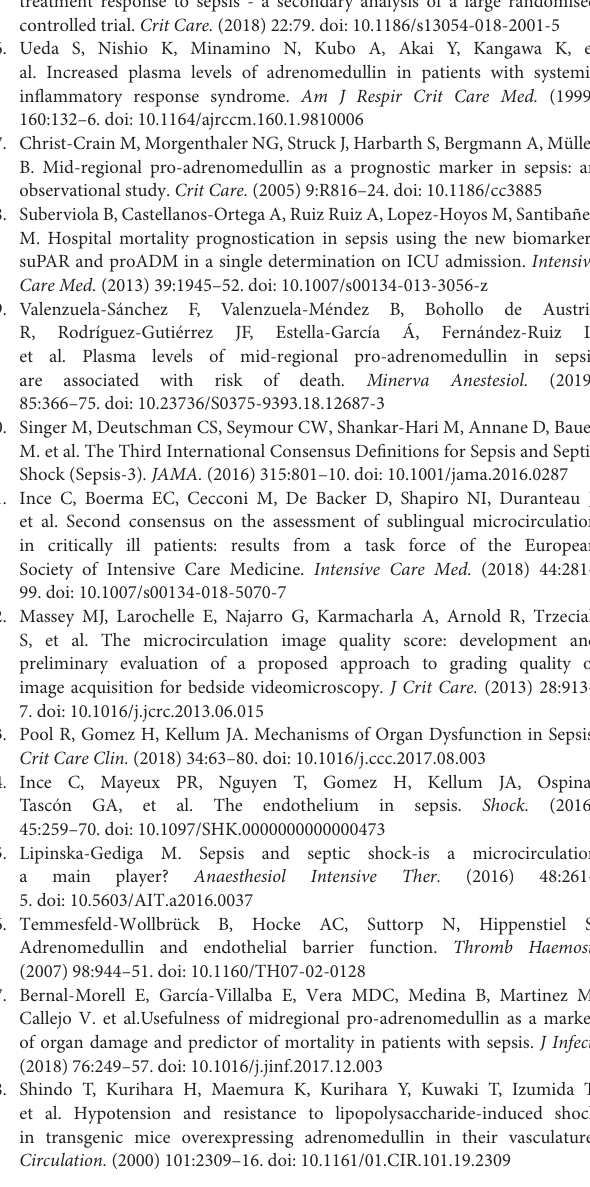
Supplementary Figure 1 | Total vessel density (TVD), proportion of perfused small vessel (PVD), and PPV of small and total vessels, De Backer score in the two groups of patients (clearance of MR-proADM inferior-to-equal or higher than 20%). The Friedman test with the Dunn’s post-hoc test. ∗ p < 0.05 for the Dunn’s post-hoc